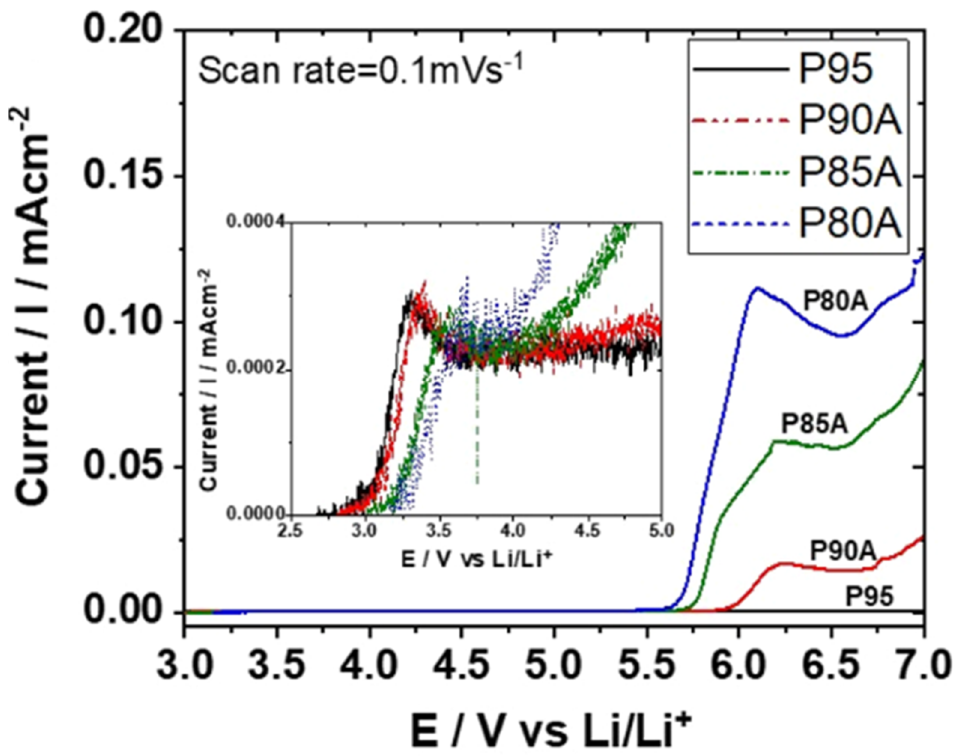
Figure 2. Electrochemical stability of DGEPEG-based polymer electrolytes with various lithium